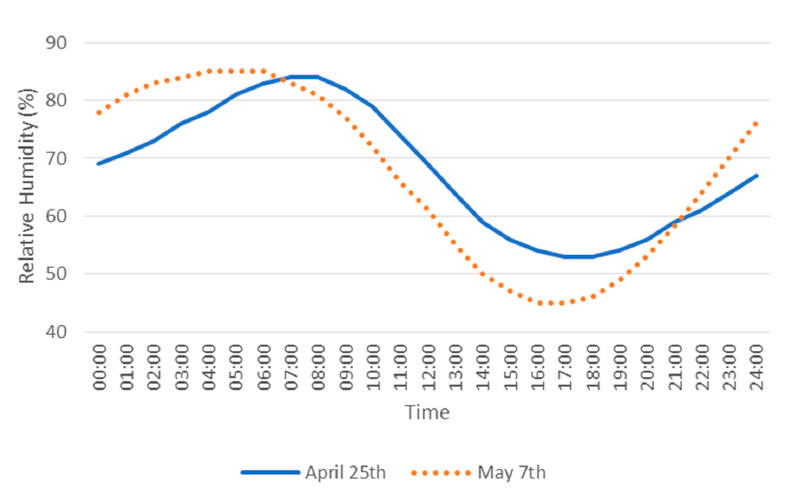
Figure 3. Relative humidity of April 25th and May 7th.